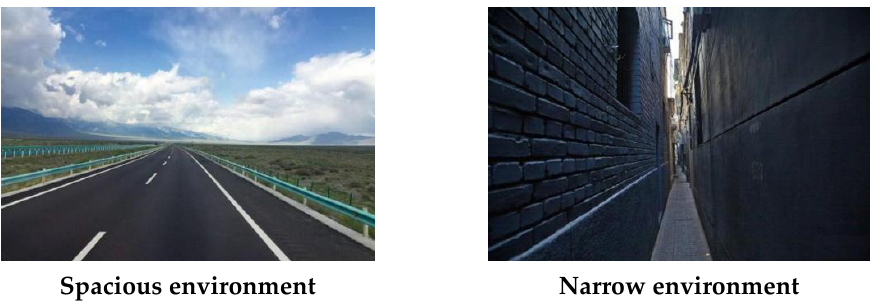
Figure 2. The photographs of spacious environment and narrow environment.